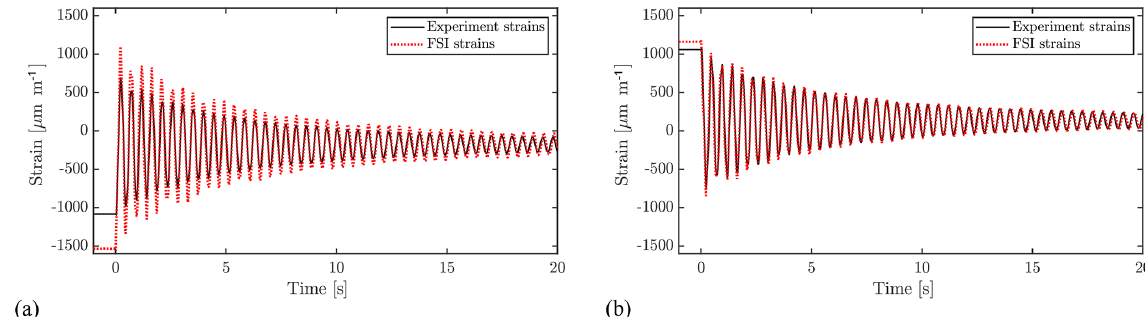
Figure 10. Strain calculated and measured at the suction side (a) and pressure side (b) of the blade at 63% of the length of the blade.